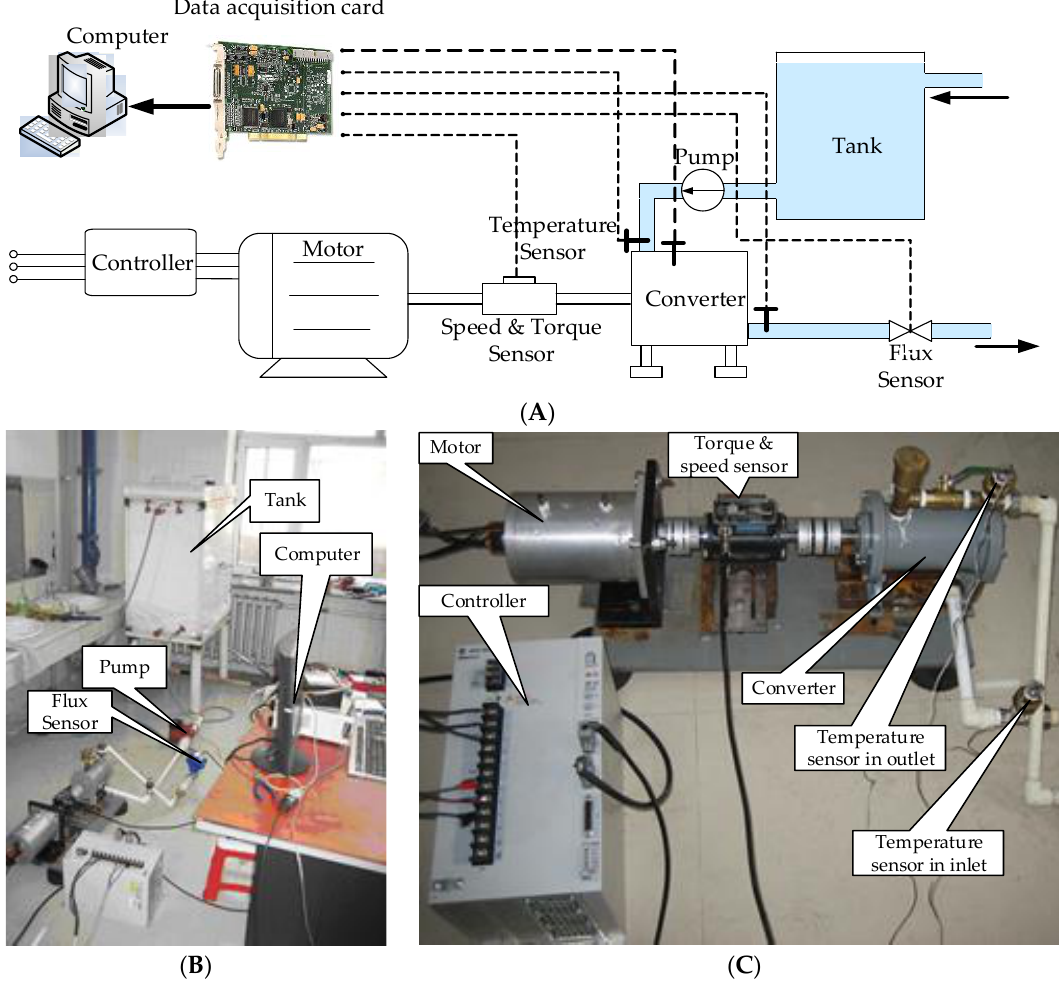
Figure 19. Experimental system. ( A ) Structural diagram; ( B ) photograph of the entire system; ( C ) photograph of the system near the converter. To display the system clearly, the insulation layer wrapped around the converter and the pipes were removed when these pictures were taken.